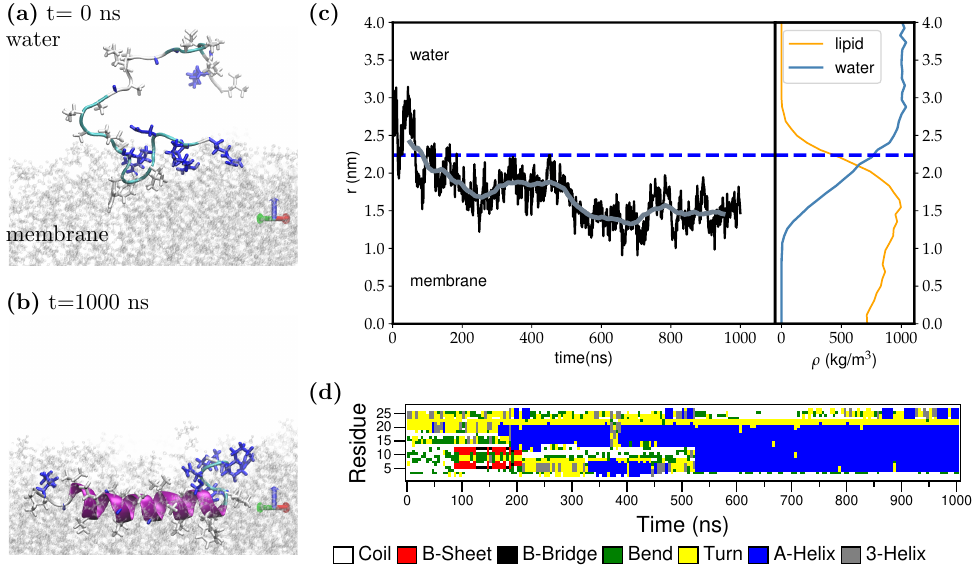
Figure 1. Wild-type Fis1(TA) adsorbs onto the lipid membrane via its carboxyl-terminus, then folds into an alpha-helical structure found within the membrane in the monotopic orientation. Snapshots for ( a ) the first contact with the membrane and ( b ) the final helical structure in monotopic orientation. ( c ) Orthogonal distance from the center-of-mass of the peptide to the membrane center-line (left) and the density profile for lipids and water above the membrane center-line (right). The water/membrane interface is shown with the dashed blue line. ( d ) Secondary structure evolution during insertion into the